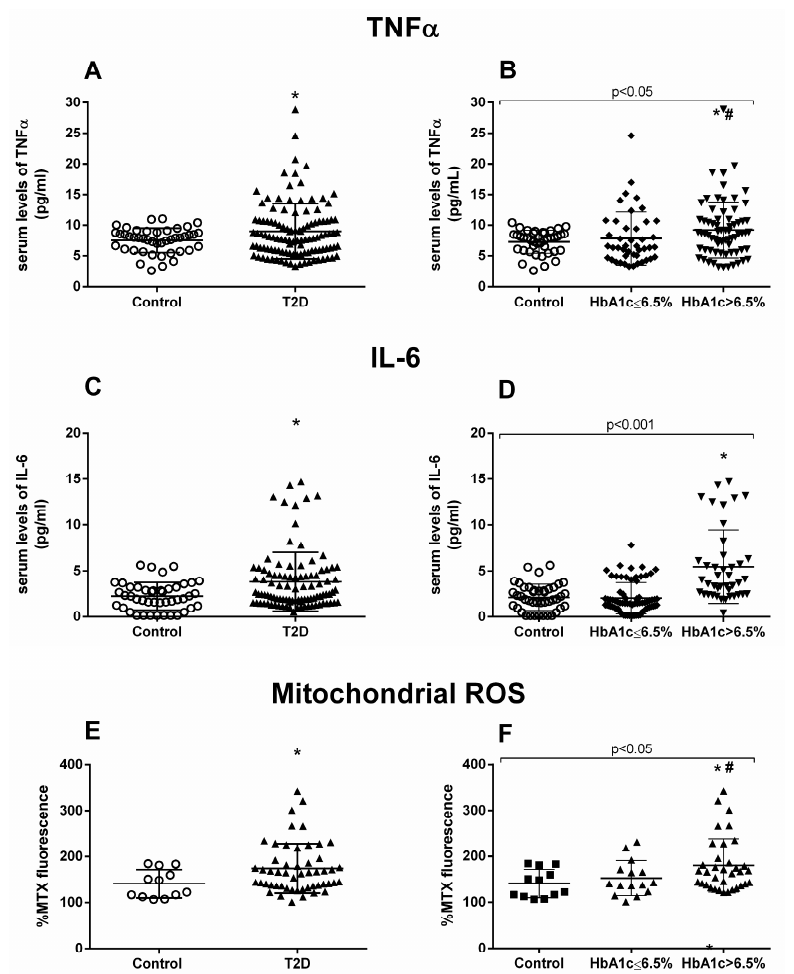
Figure 1. TNF α , IL-6, and mtROS measurements. Serum levels of proinflammatory cytokines TNF α ( A , B ) and IL-6 ( C , D ), and fluorescence levels of mtROS ( E , F ). Differences between control and T2D groups ( A , C , E ) or between control, well-controlled (HbA 1c ≤ 6.5%) and poorly controlled diabetic groups (HbA 1c > 6.5%) ( B , D , F ) are shown. Statistical analysis was performed using a t-test to compare two groups, and using ANOVA with Bonferroni post-test for three groups. * p < 0.05 vs. control; # p < 0.05 vs. T2D HbA1c < 6.5%.